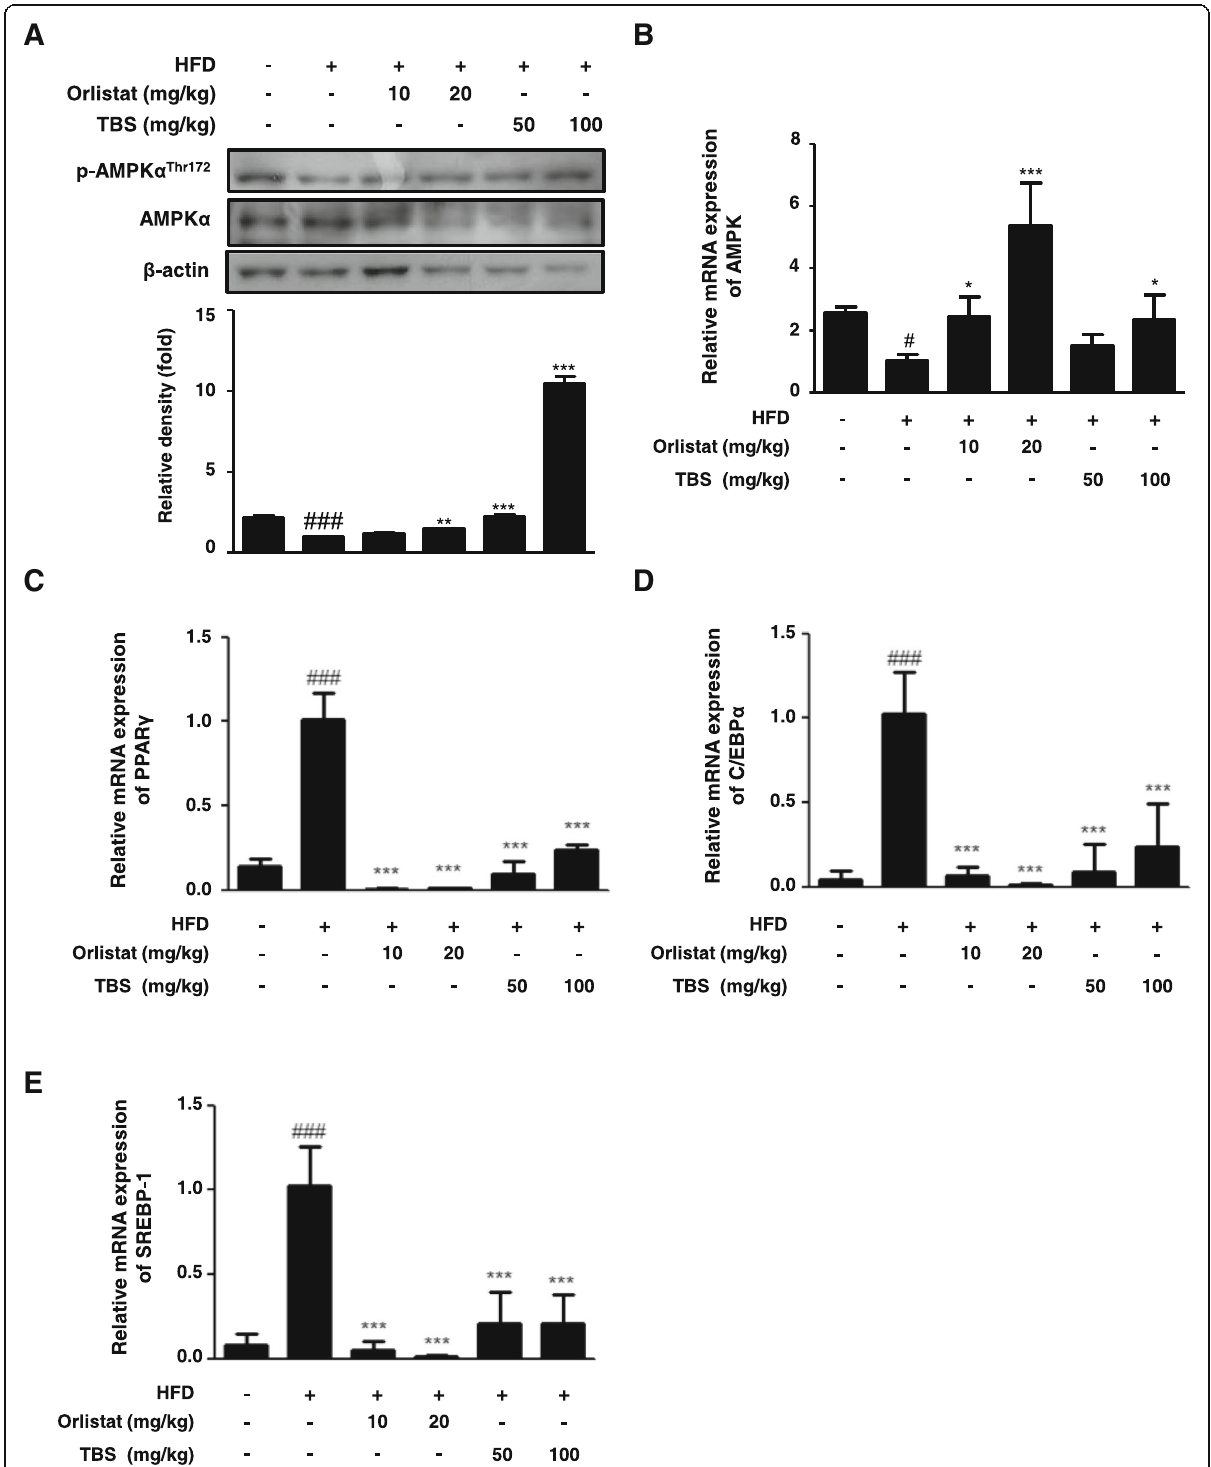
Fig. 6 Effects of TBS on liver tissue the expression of p-AMPK, AMPK, PPAR γ , C/EBP α , and SREBP1. Total protein and RNA prepared from liver tissue were used to measure the expression of protein of ( a ) p-AMPK and the levels of mRNA of ( b ) AMPK, ( c ) PPAR γ , ( d ) C/EBP α , and ( e ) SREBP1 by western blotting and qRT-PCR. Densitometric analysis was performed using ImageJ ver. 1.50i. The values represent the mean ± S.D. of three independent experiments. # p < 0.05 and ### p < 0.001 vs. the control group; * p < 0.05, ** p < 0.01, and *** p < 0.001 vs. HFD